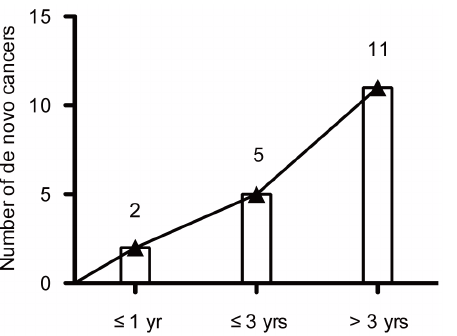
Figure 2. The number of denovo cancer cases developed in the different follow-up years after liver transplantation.